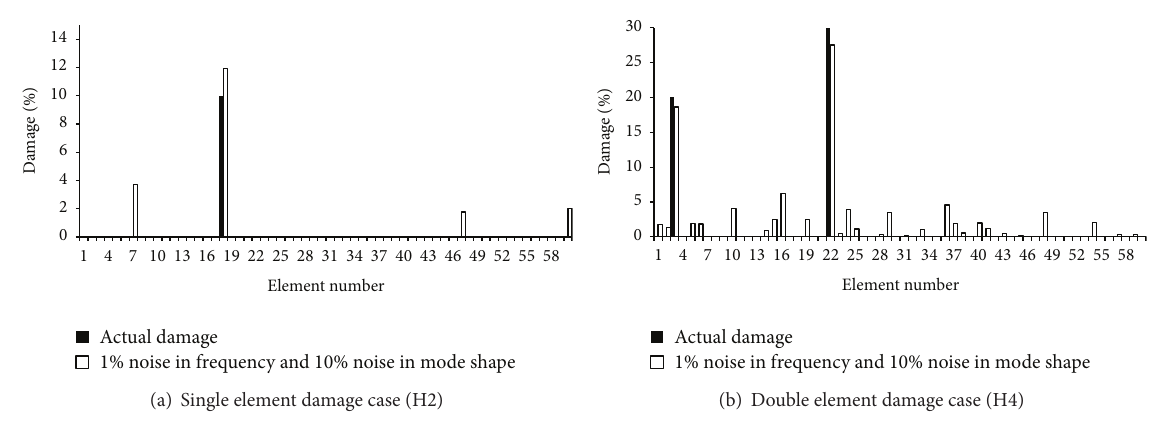
Figure 10: Damage assessment results for H2 and H4 conditions in space frame